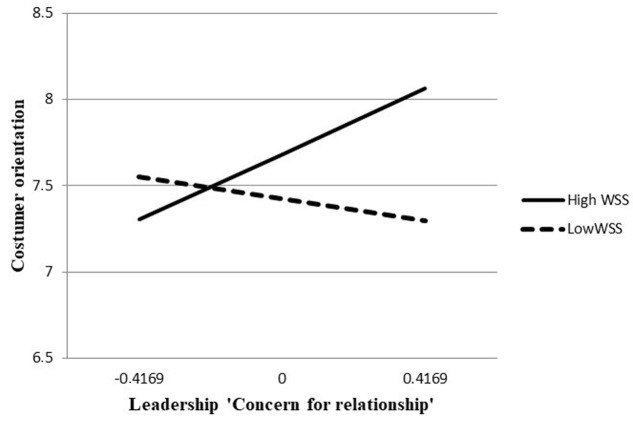
Moderation analysis.